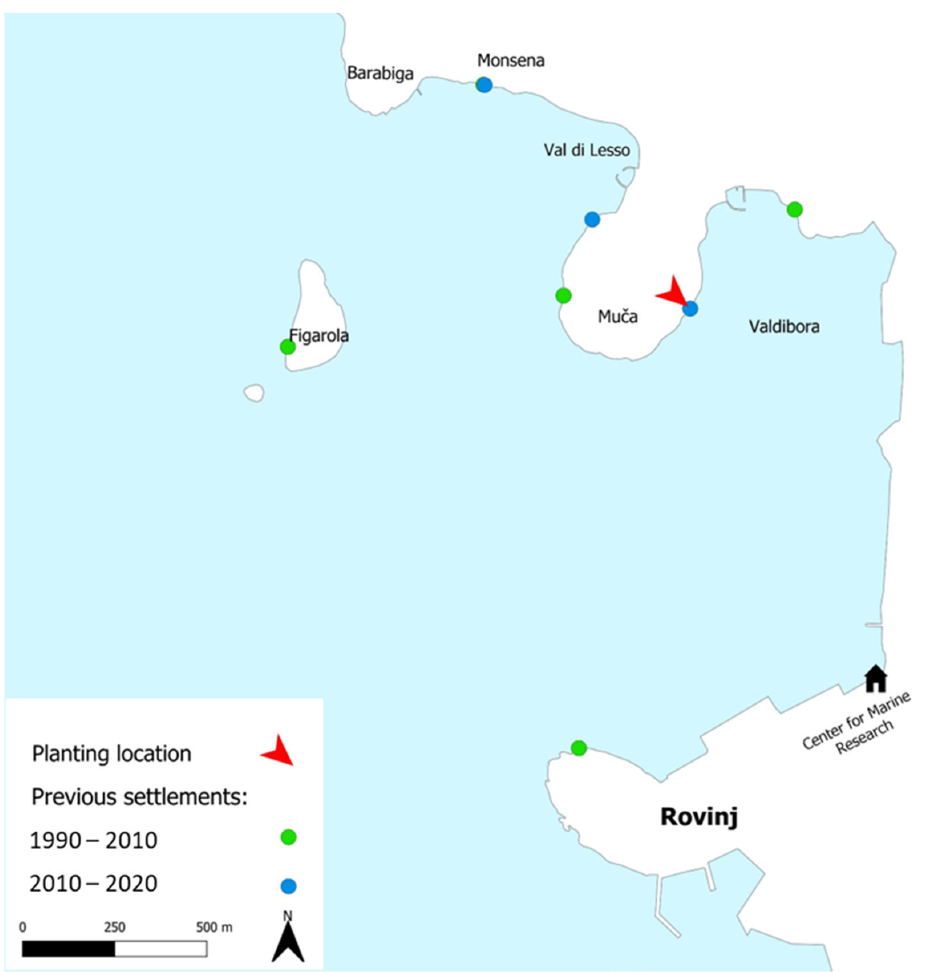
Figure 9. Past distribution of Fucus virsoides settlements in the Rovinj area. Area of planting is shown with a red mark.